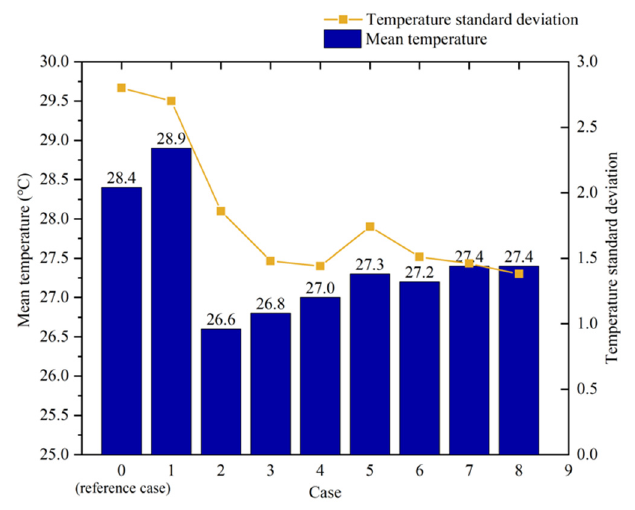
Figure 13. The change in the average air temperatures of the back door of the rack B4 in cases 0–8.